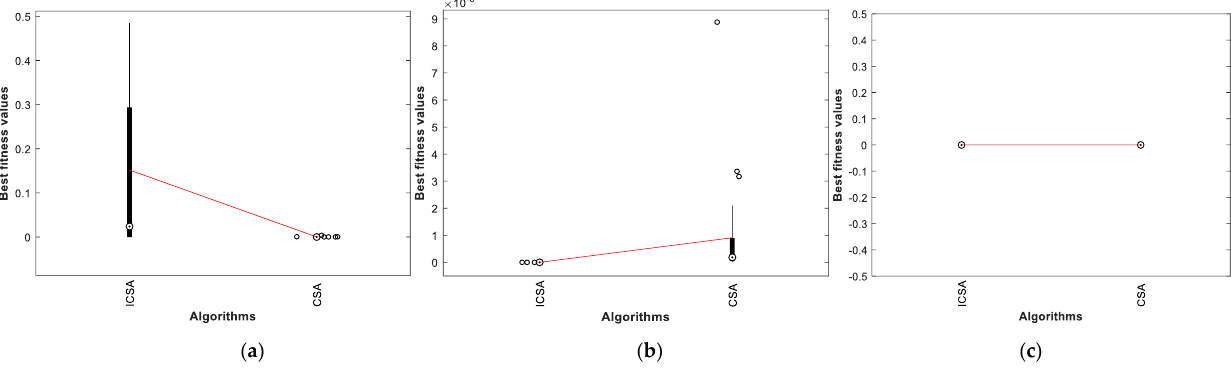
Figure 27. Boxplot of CSA and ICSA for various test cases : ( a ) Boxplot for F4; ( b ) Boxplot for F5; ( c ) Boxplot for F6.